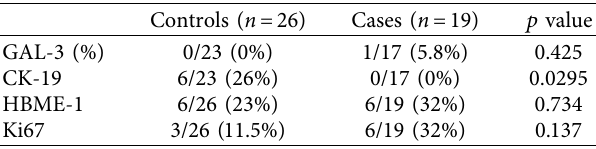
Table 2: Immunocytochemistry